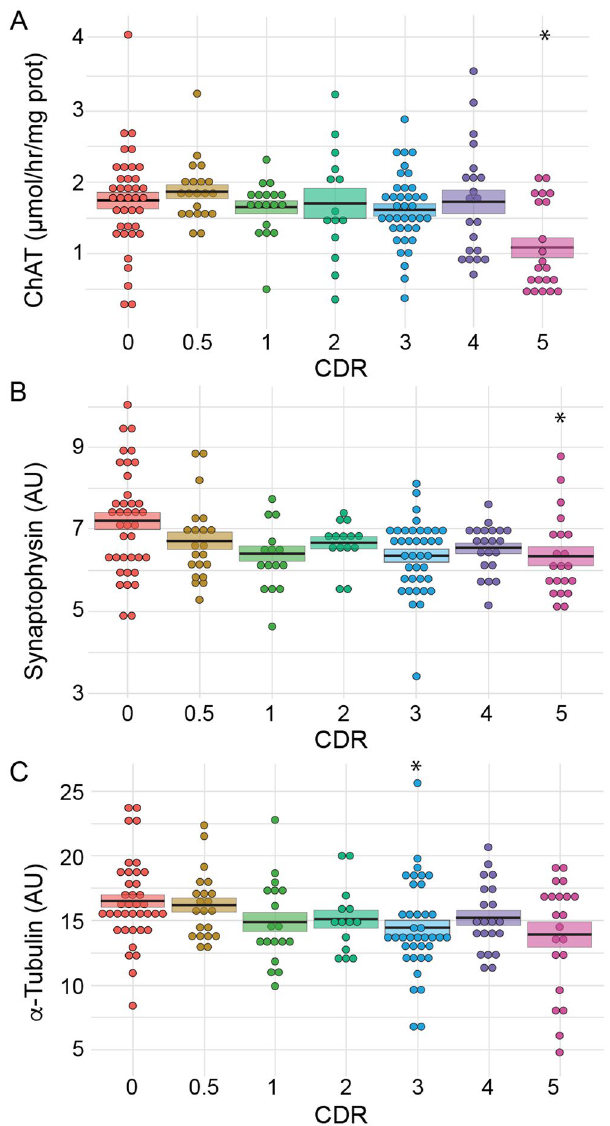
Figure 7. Dot plot representation of the effect of dementia on ChAT, synaptophysin and α -tubulin expression. ChAT activity ( A ) was measured in the BA9 extracts, whereas synaptophysin ( B ) and α -tubulin ( C ) were detected by western blot. Corresponding values were plotted against the CDR scores. Dots represent individual values. The mean is represented by the black line, and the SEM is represented by the coloured box. ChAT and synaptophysin expression were significantly reduced in individuals with CDR scores of 5 (p < 0.05), whereas α -tubulin expression was only modified at CDR scores of 3. * p <